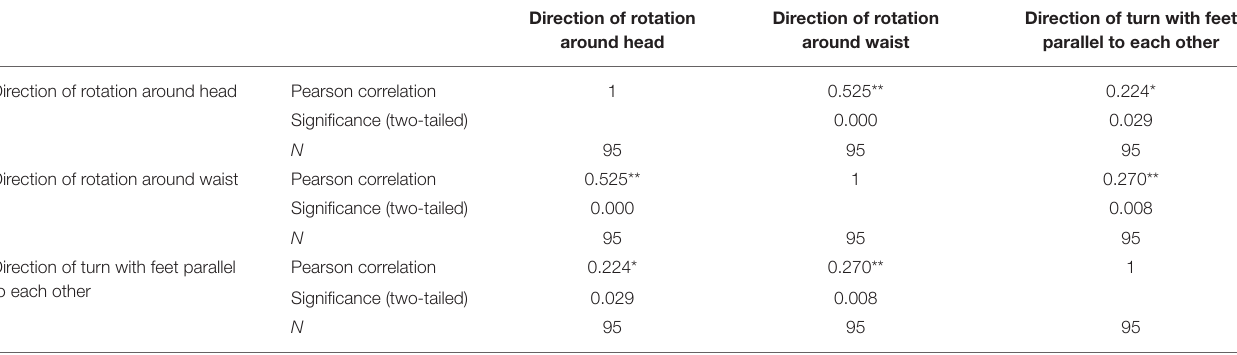
Direction of rotation Direction of rotation Direction of turn with feet around head around waist parallel to each other